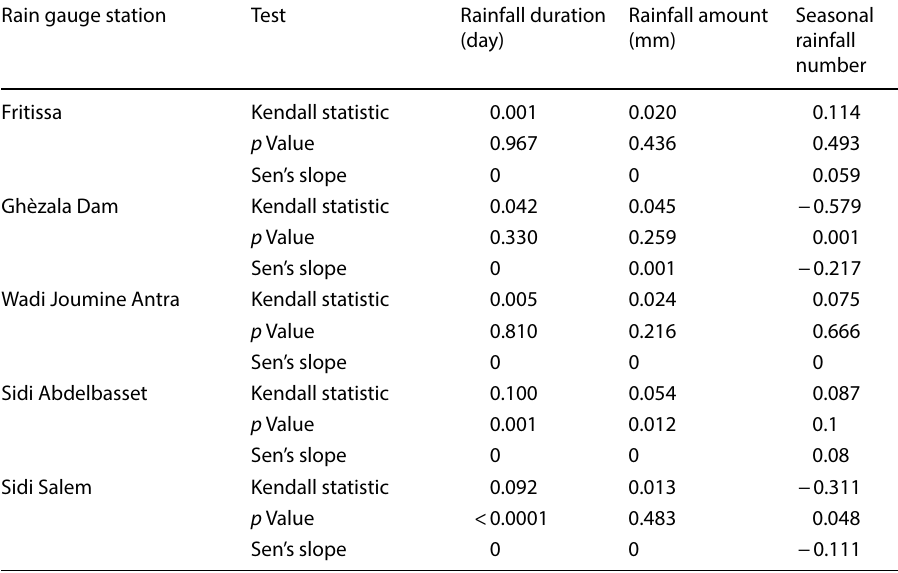
Signification level (%): 5, Confidence interval (%) (Sen’s